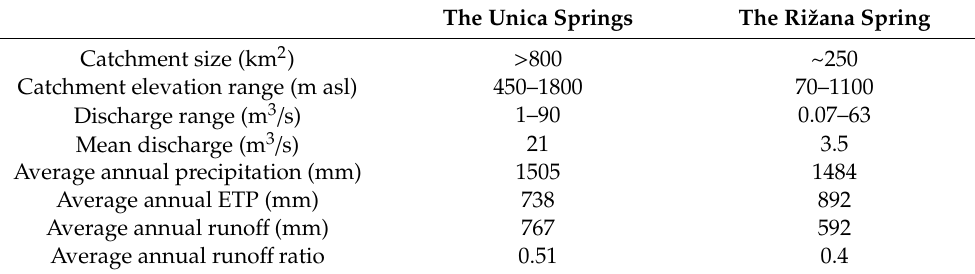
Table 1. Summarized main characteristics of the study